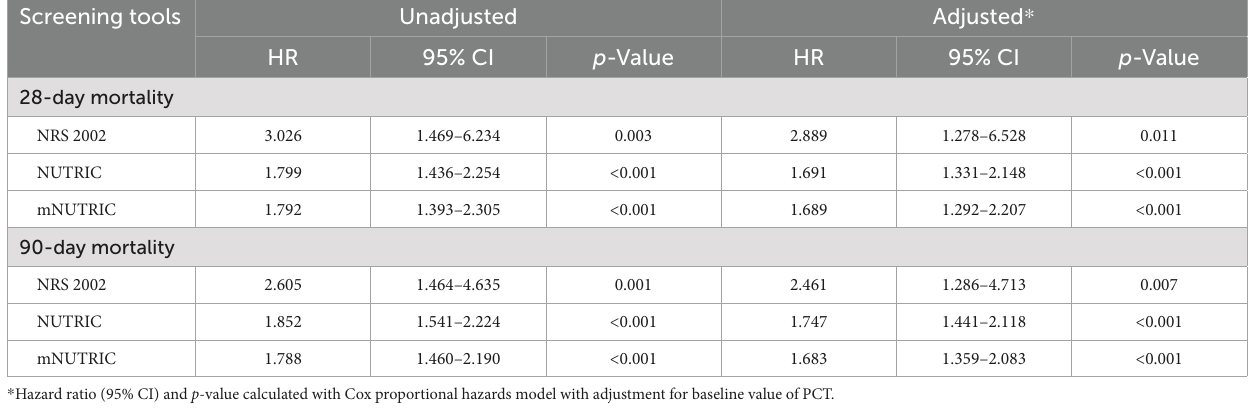
TABLE 4 Cox proportional hazards regression model for mortalities. Screening tools